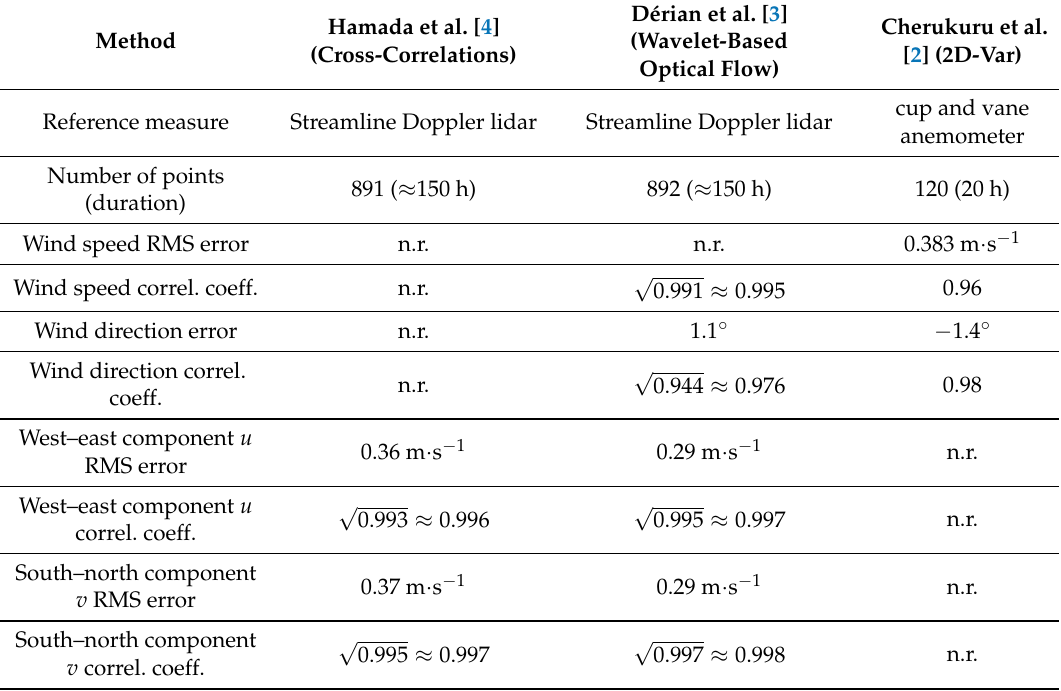
Table 2. Accuracy of wind field retrieval algorithms measured on 10-min averages. Values for Hamada et al. [4] are from Tables 4 and 5. Values for Dérian et al. [3] are from Tables 2 and 3 and Section 5.a.4. Zhou et al. [1] did not report on the accuracy of wind retrieval; values listed here for the 2D-VAR are obtained from Cherukuru et al. [2] (Figure 2 and Table 1). “n.r.” stands for “not reported”. Note that horizontal wind vectors derived from the Streamline Doppler lidar resulted from a Doppler beam swinging technique that placed off-zenith sample volumes for radial velocities approximately 210 m apart, whereas the cup and vane anemometer is sampled at essentially one point in the atmosphere. Dérian et al. [3] Cherukuru et al. Hamada et al. [4] (Wavelet-Based Method [2] (2D-Var) (Cross-Correlations) Optical Flow) cup and vane Reference measure Streamline Doppler lidar Streamline Doppler lidar